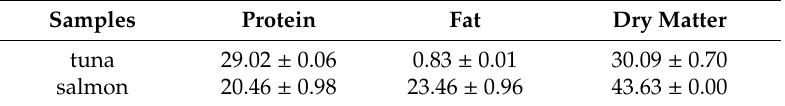
Table 7. Chemical composition of sashimi tuna fillets and salmon fillets with skin (in